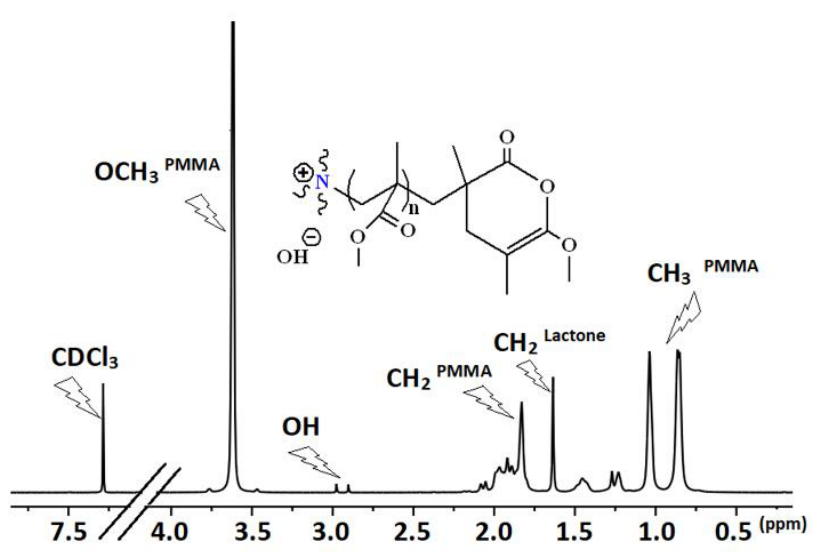
Figure 3. 1 H-NMR spectrum of PMMA in CDCl 3 obtained using ZIF-L at 140 ° C (Table 1, entry 3).